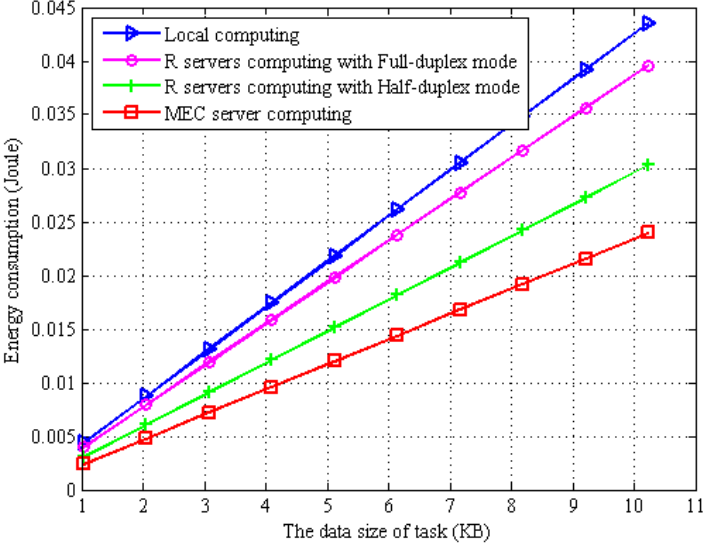
Figure 2. The energy consumption vs. different task size and different task computing.